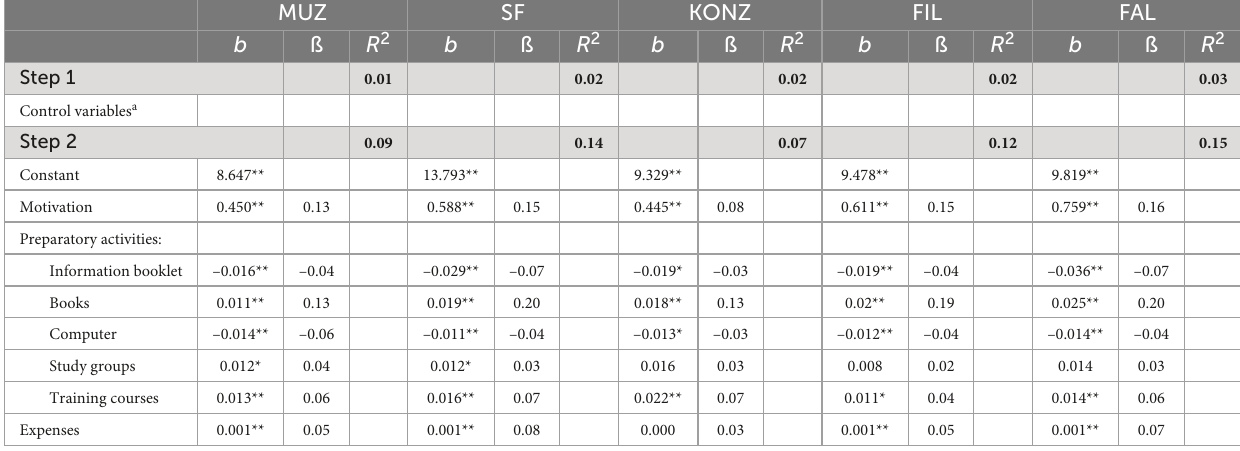
TABLE 8 Hierarchical univariate multiple regression analyses predicting the less complex TMS-subtests.